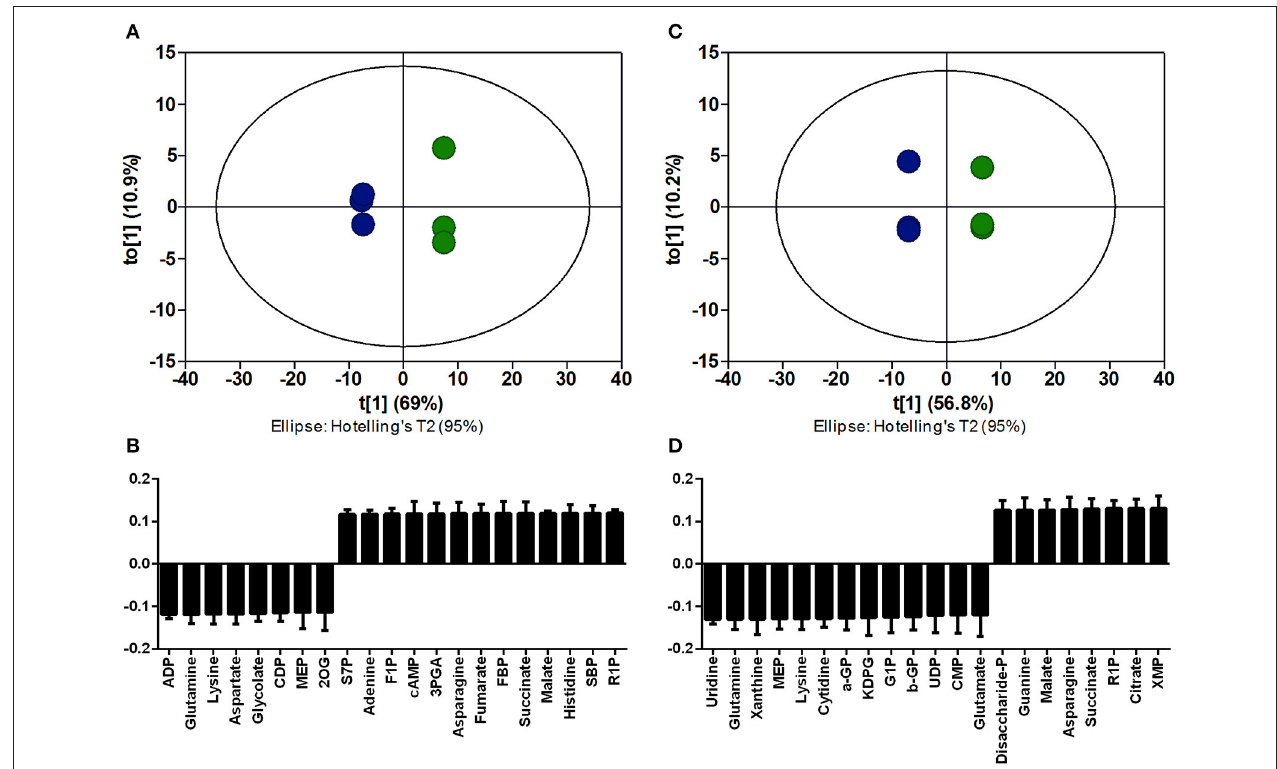
FIGURE 2 | Orthogonal partial least squares discriminant analysis (OPLS-DA) for intracellular metabolites of B. subtilis WB in comparison to B. subtilis 1 spo (reference) without (A,B) and with (C,D) γ -PGA production. The score plot for triplicate metabolome samples of the reference (blue) and B. subtilis WB (green) strains without (A) and with (C) γ -PGA production is given. The loading values without (B) and with (D) γ -PGA production for metabolites highly contributing to the separation are presented. High loading values correspond to increased metabolite concentrations for B. subtilis WB (PX43- pgs ). 2OG, 2-oxoglutarate; 3PGA, 3-Phosphoglycerate; ADP, Adenosine 5 ′ -diphosphate; a-GP, α -glycerophosphate; b-GP, β -glycerophosphate; cAMP, 3 ′ ,5 ′ -cyclic AMP; CDP, cytidine 5 ′ -diphosphate; CMP, cytidine 5 ′ -monophosphate; CTP, cytidine 5 ′ -triphosphate; DHAP, dihydroxyacetone phosphate; F1P, fructose-1-phosphate; FBP, fructose-bisphosphate; G1P, glucose-1-phosphate; GAP, D -glyceraldehyde 3-phosphate; GDP, guanosine 5 ′ -diphosphate; KDPG, 2-keto-3-deoxy-6-phosphogluconate; MEP, methyerythritol 4-phosphate; PEP, phosphoenolpyruvate; R1P, ribose-1-phosphate; R5P, ribose-5-phosphate; S7P, sedoheptulose-7-phosphate; SBP, sedoheptulose-1,7-bisphosphate; UDP, uridine 5 ′ -diphosphate; XMP, xanthosine 5 ′